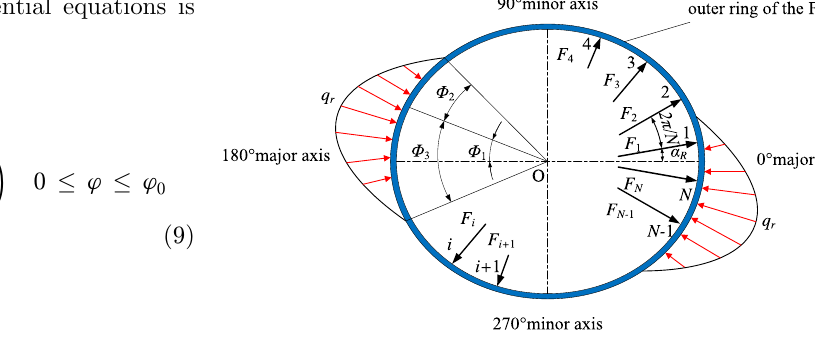
Fig. 5. Loading diagram of outer ring of the FB with N balls ( N ≧